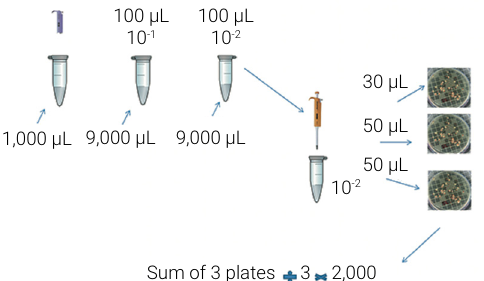
Figure 3. Schematic representation of microbiologic collection in the initial, intermediate, and final stages